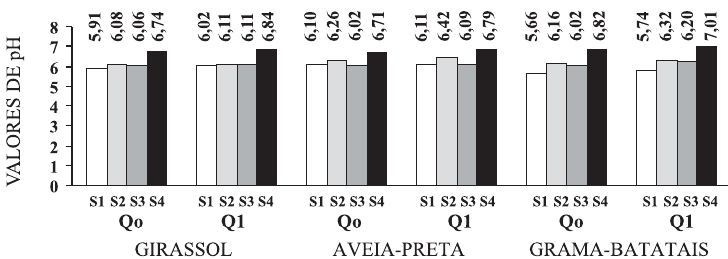
Figura 2. Valores de pH dos solos dos tratamentos ao final do experimento em casa de vegetação. Qo: ausência de quelante; Q1: aplicação de 20 mmol kg -1 de ácido cítrico no